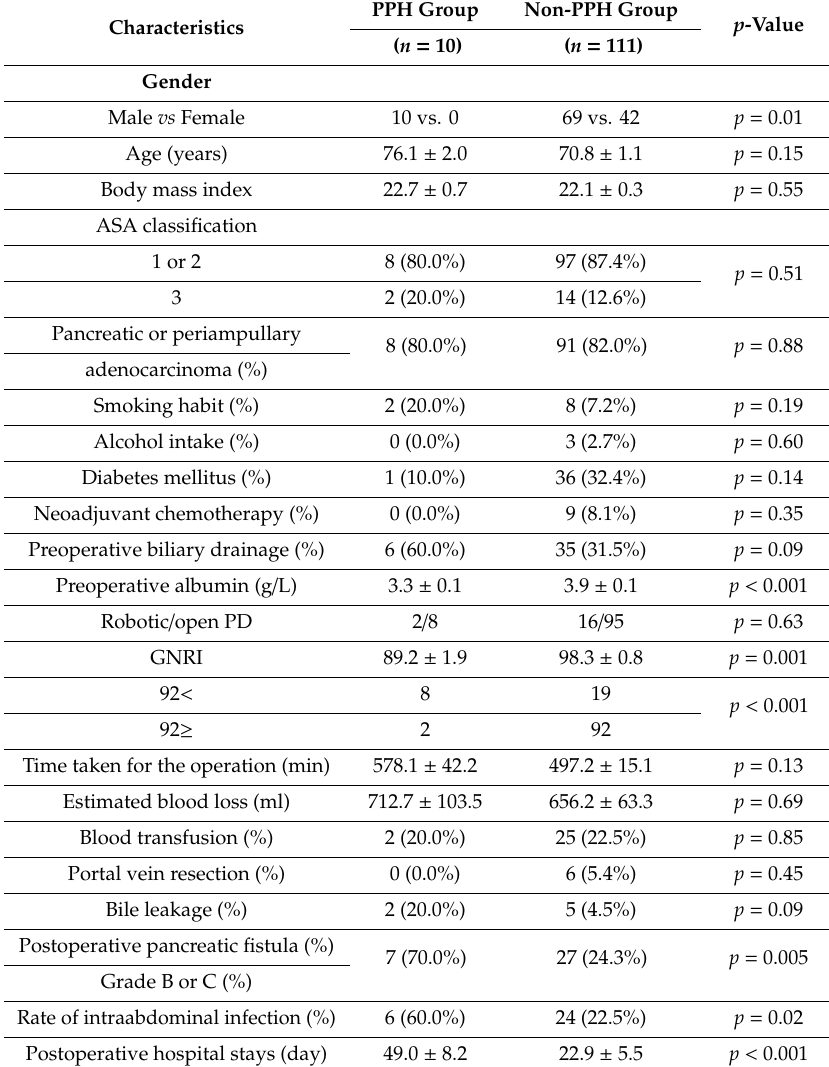
Table 1. Results of univariate analysis. The analysis revealed significantly higher incidence of PPH in those with GNRI <